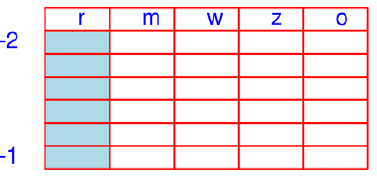
Figure 8. The h -list after sorting based on retention time.